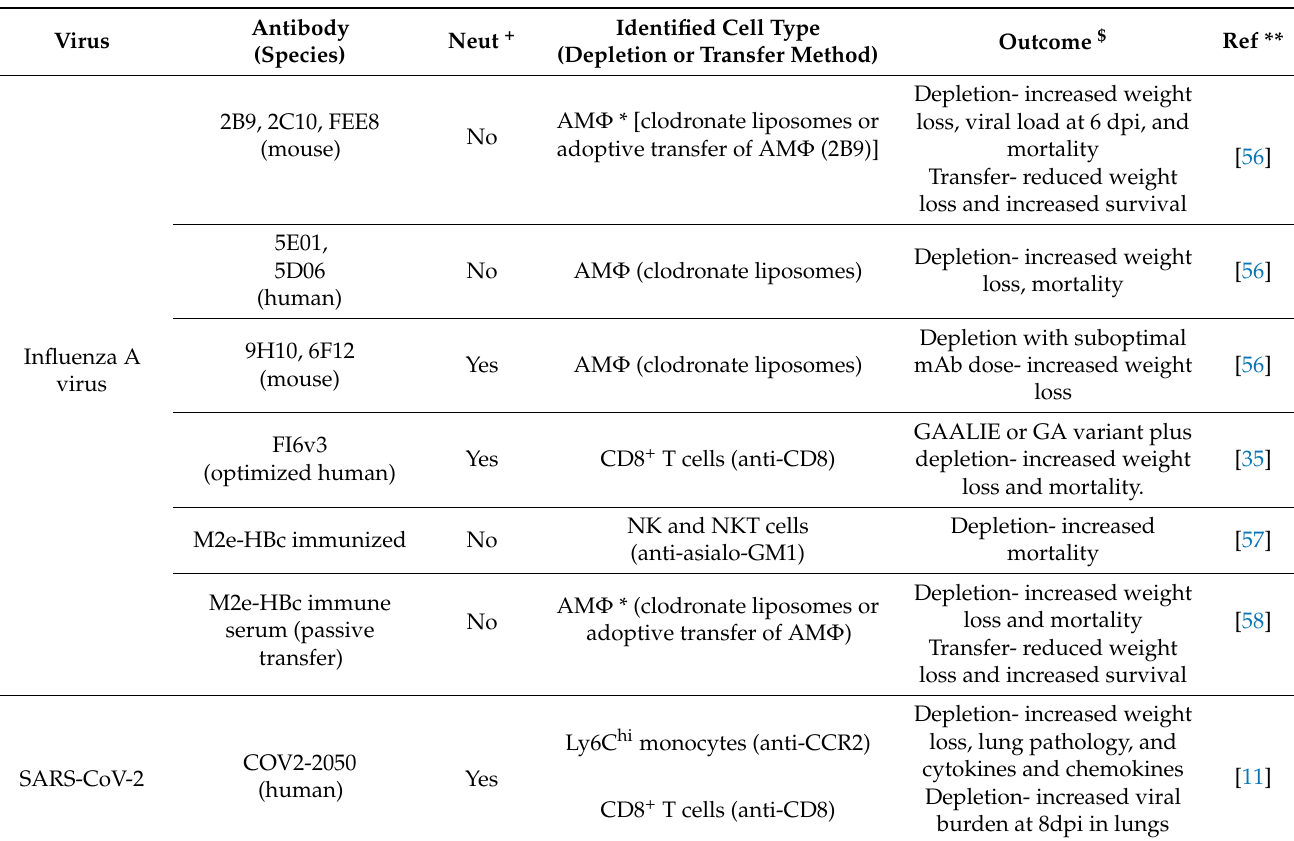
Table 2. Summary of in vivo depletion or adoptive transfer studies to identify cell types involved in Ab-mediated protection.